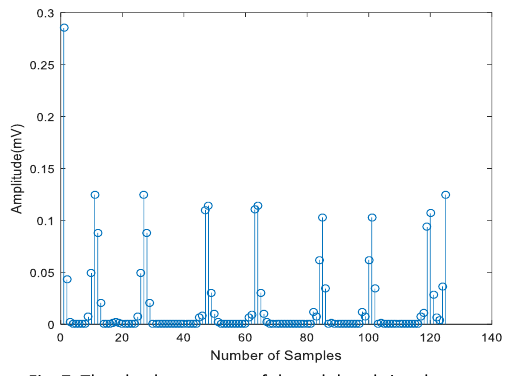
Fig. 7. The absolute energy of the sub band signal 𝑥 000𝑎 .